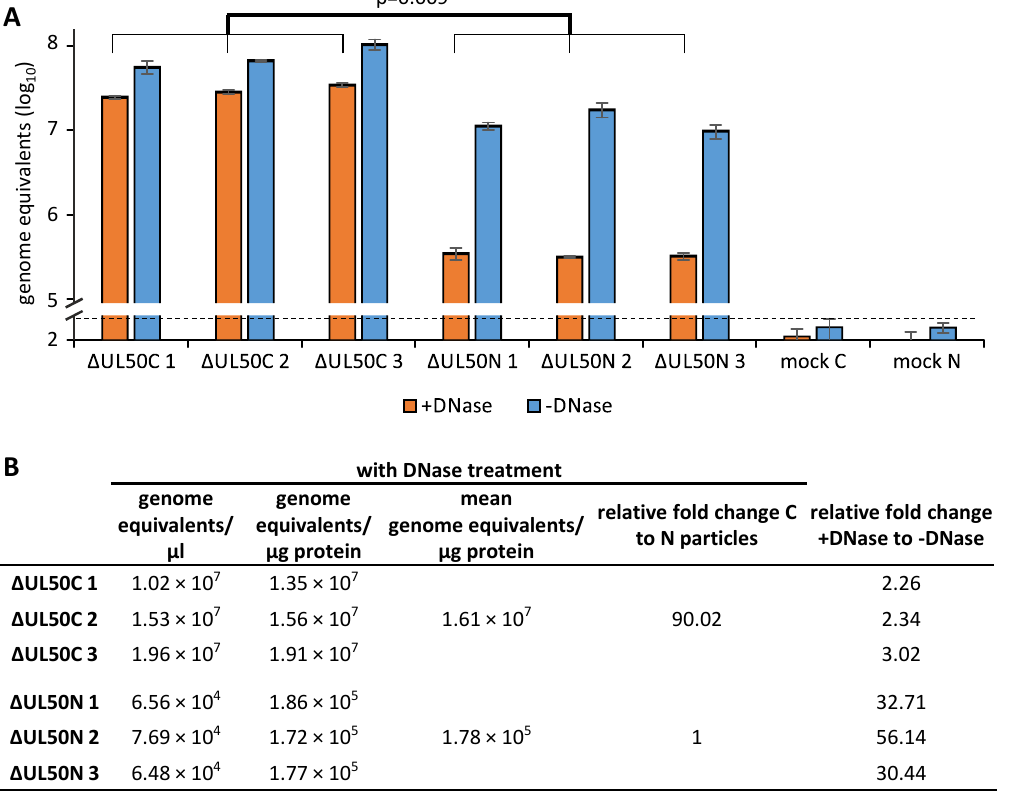
Figure 7. Purified ∆ UL50N particles comprise a reduced quantity of viral genome packaging, and an association with DNase-sensitive unpackaged genomes. ( A ) Samples of sucrose cushion-purified ∆ UL50C and ∆ UL50N particles were adjusted to identical protein levels and either subjected to DNase digestion (+DNase) or remained untreated ( − DNase) prior to the isolation of viral genomic DNA. In both cases, viral genomic loads were determined by virus-specific qPCR. Mean values of triplicates ± SD are given. Statistical significance between the mean values of ∆ UL50C 1–3 and ∆ UL50N 1–3 was calculated by the Student’s t -test (**, p = 0.009). ( B ) Calculation of genome equivalents per µ g protein in the respective aliquots. Relative fold change between the mean values of ∆ UL50C and ∆ UL50N particles and between the settings with (+) and without ( − ) DNase treatment are given. Note the drastic change in the detection of genome equivalents after DNase treatment (+) determined for the ∆ UL50N virus